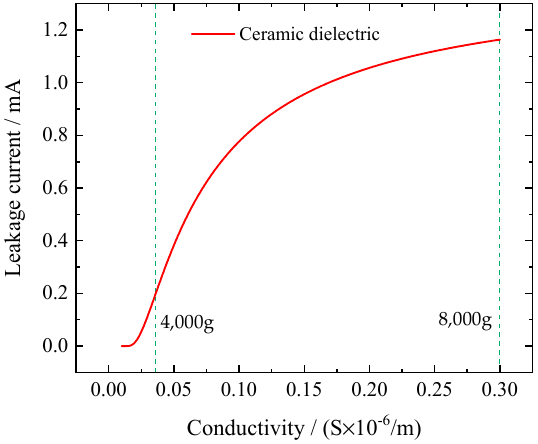
Figure 15. Relationship between leakage current and ceramic conductivity.